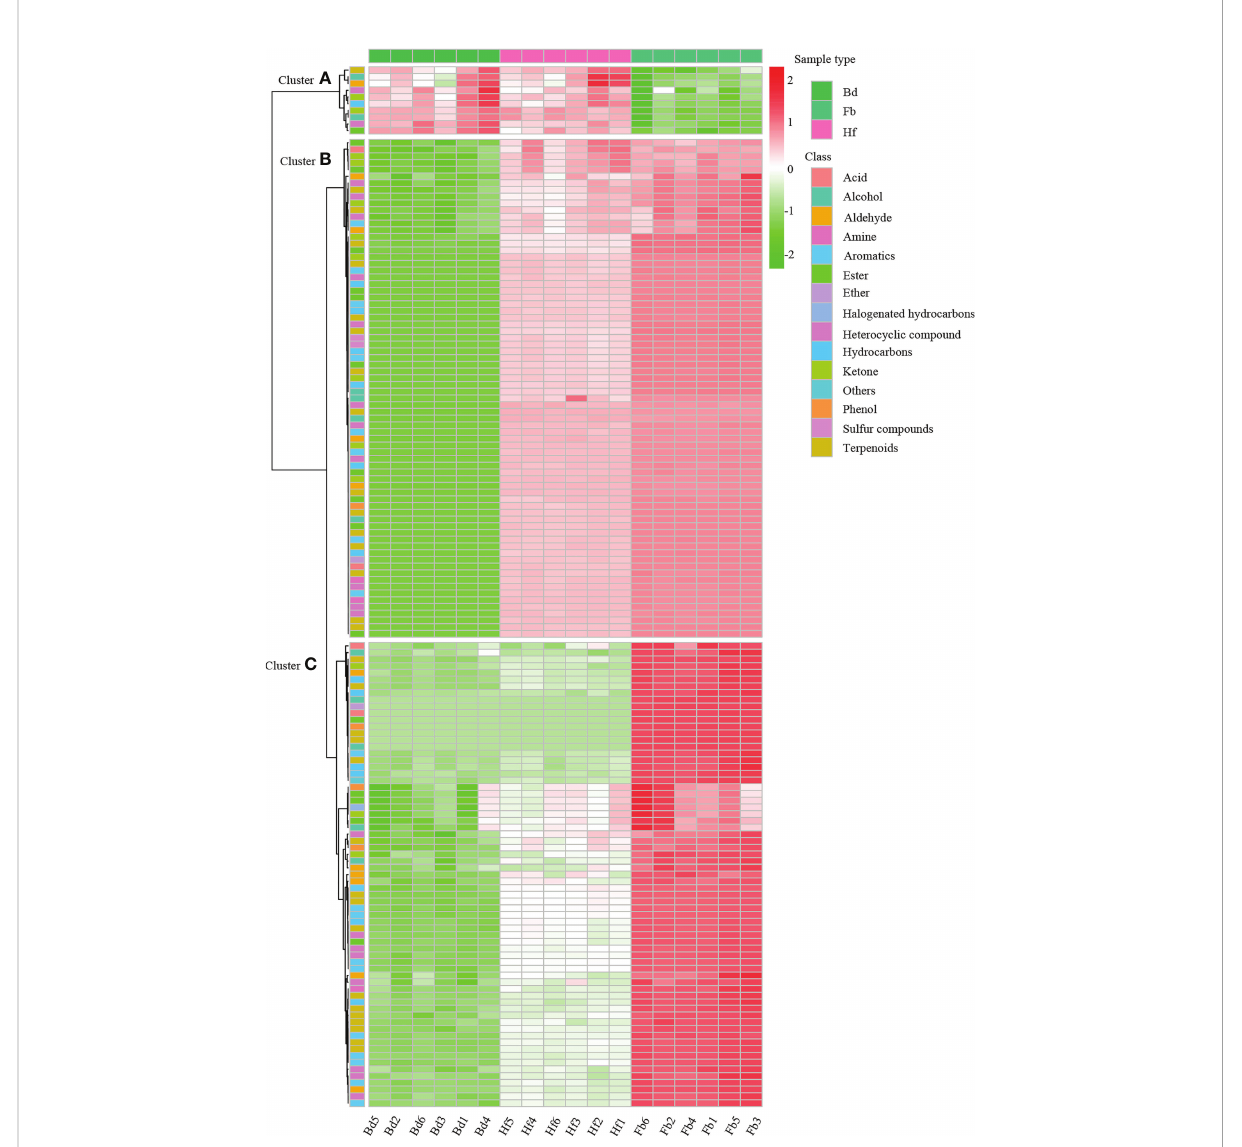
FIGURE 4 The accumulation pattern of 153 DVOCs among Bd, Hf and Fb groups in D. chrysotoxum . VOCs of cluster A were all signi fi cantly down- accumulated at Hf or Fb, and VOCs of cluster B and C were all signi fi cantly up-accumulated at Hf or Fb. In the graphic, red color represents up- accumulated VOCs and green color represent down-accumulated